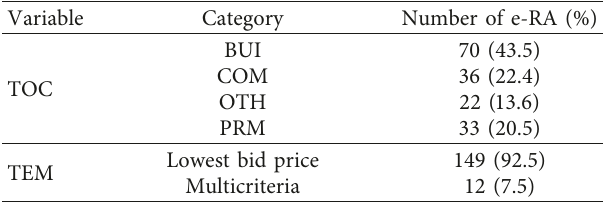
Table 3: Frequency tables for the categorical variables TOC (type of contract) and TEM (type of evaluation